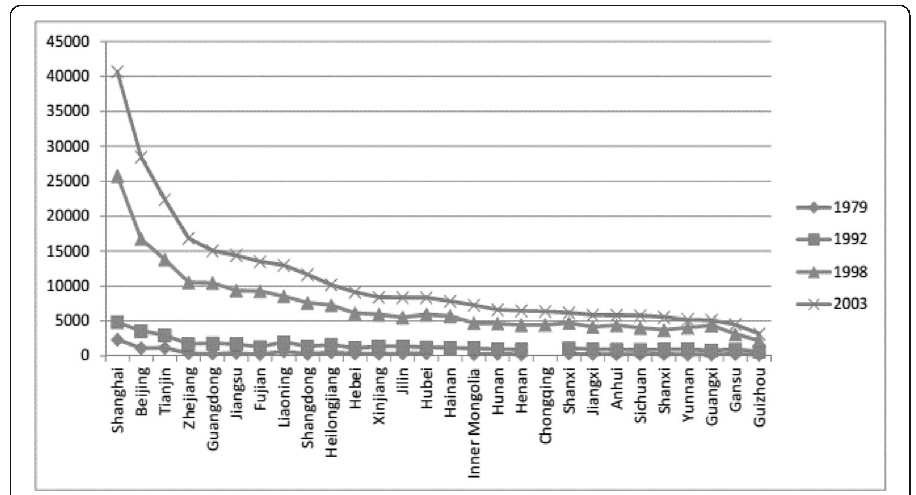
Fig. 1 Economic development from 1979 to 2003, measured by provincial-level per capita GDP ( Yuan ) — X- axis indicates four state-designated municipalities and 24 provinces in China; Y-axis indicates per capita GDP in Chinese yuan ; the line marked with diamonds indicates per capita GDP in 1979, the line marked with squares indicates per capita GDP in 1992, the line marked with triangles indicates per capita GDP in 1998, and the line marked with crosses indicates per capita GDP in 2003. (National Bureau of Statistics of